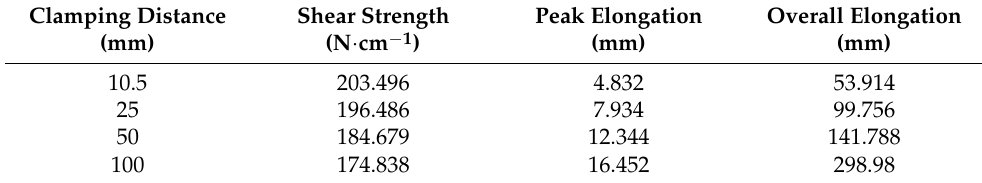
Table 4. Tensile shear test results of the